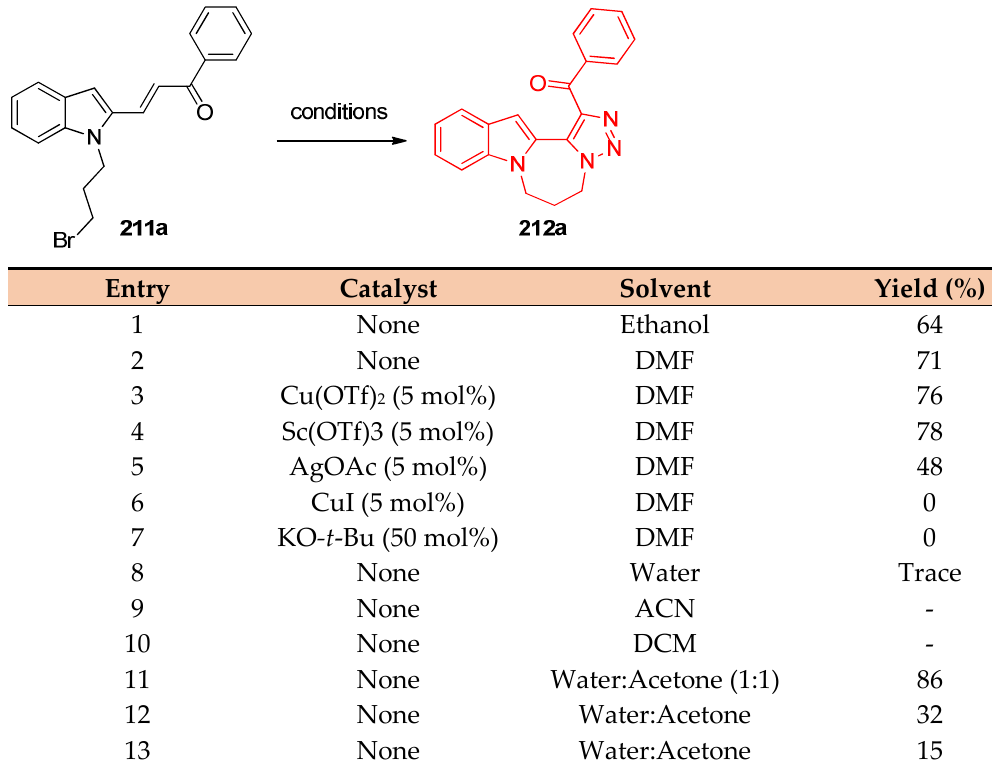
Scheme 80. Proposed mechanism for the formation of the azido alcohol 188a .